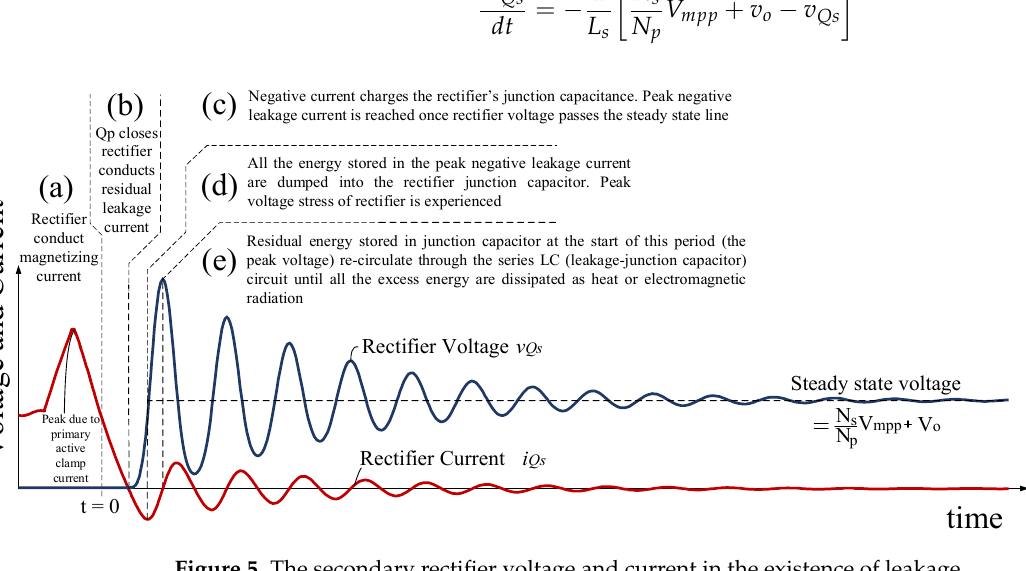
Figure 5. The secondary rectifier voltage and current in the existence of leakage.